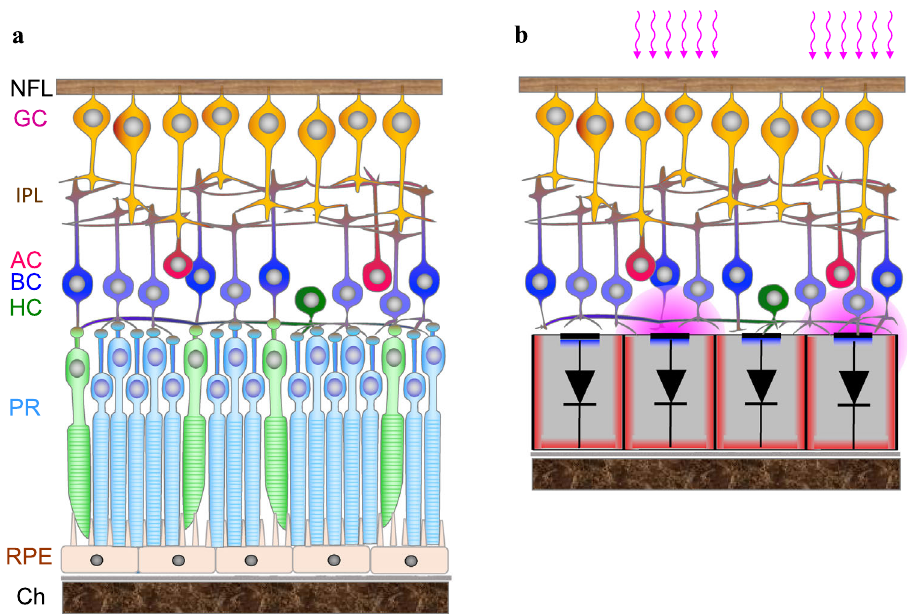
Fig.1|Diagramsofthehealthyanddegenerateretinas.a Diagramofthecellular layers in healthy retina, including the Choroid (Ch), Retinal Pigmented Epithelium (RPE),Photoreceptors(PR),Horizontalcells(HC),Bipolarcells(BC),Amacrinecells (AC), Inner Plexiform Layer (IPL), and Ganglion cells (GC), whose axons comprise